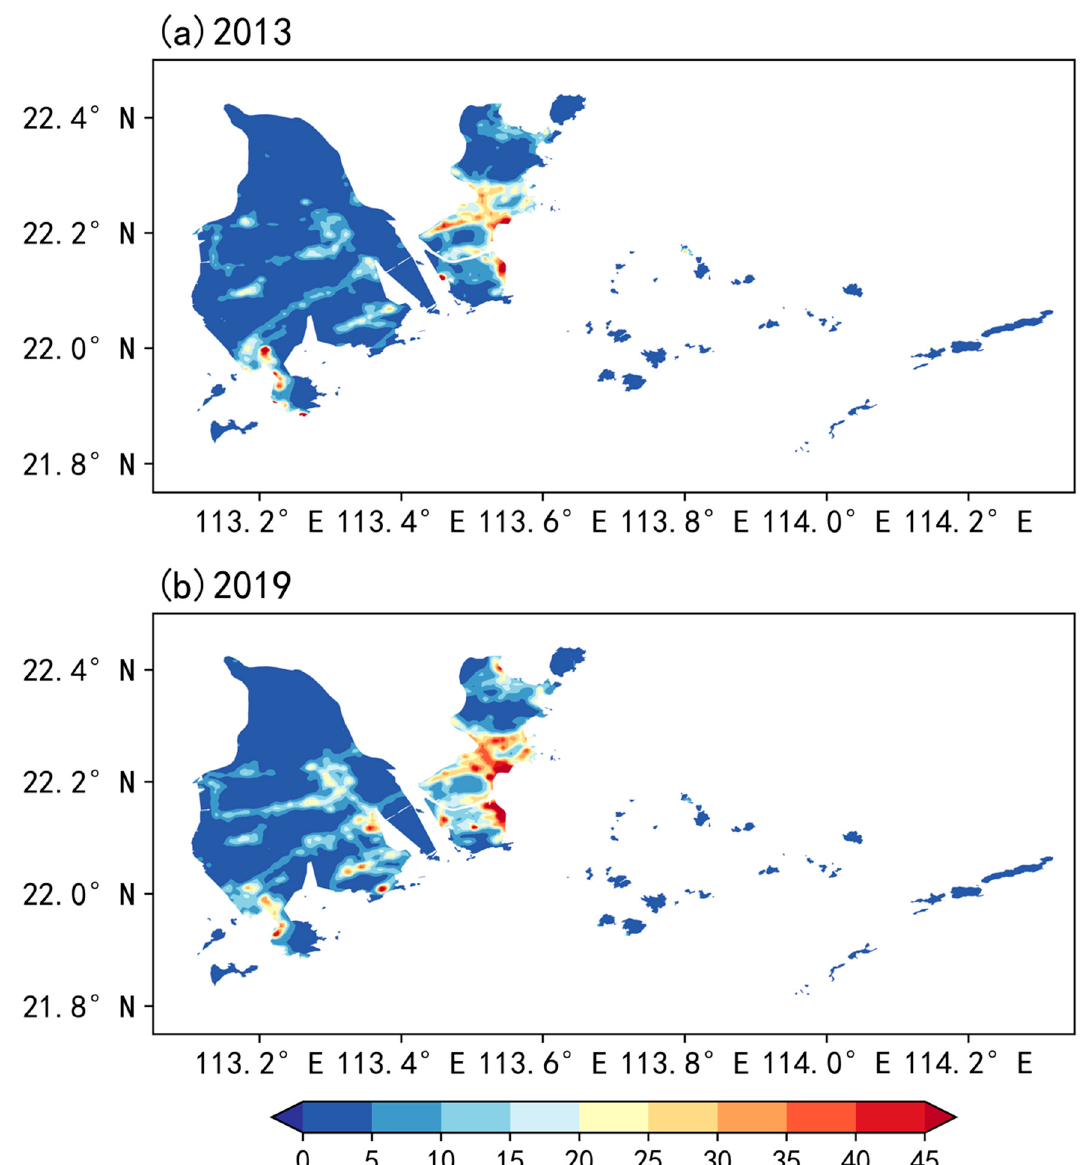
Figure 7. Geographic distribution of the NLI over Zhuhai in ( a ) 2013 and ( b ) 2019.